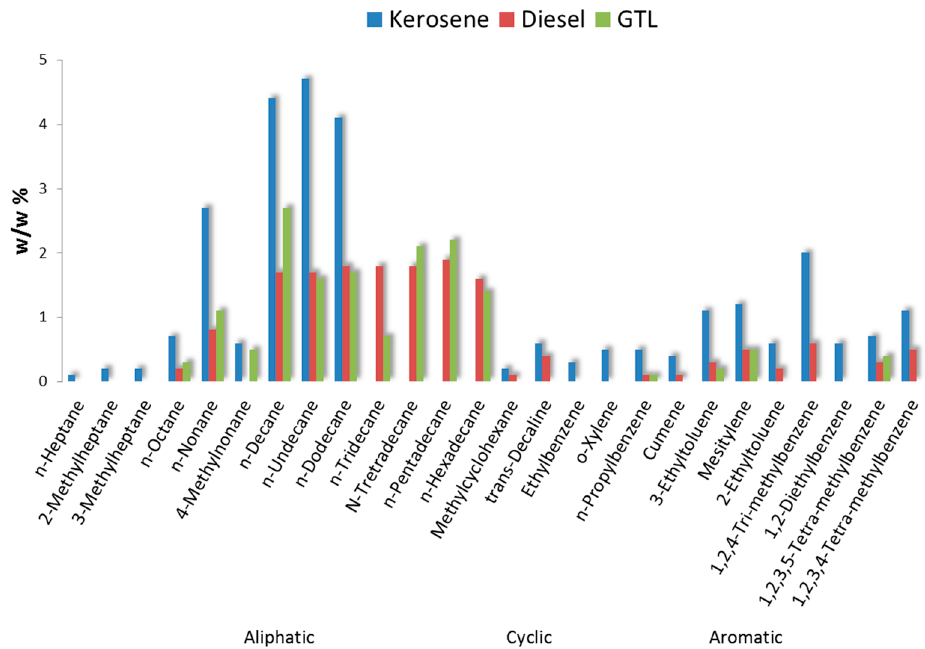
Figure 2. Analysis of fuels for a selection of 180 VOC expressed as a weight percentage ( w / w %). GTL = Gas-to-liquid fuel (see text for more information).